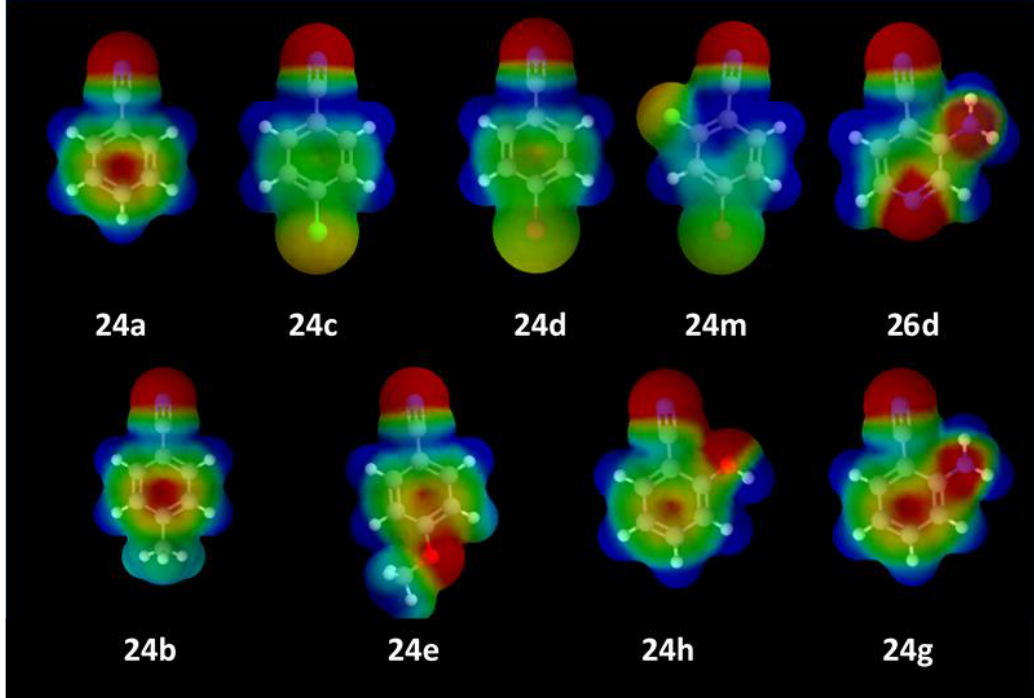
Figure 5. MEP diagrams. Blue indicates electron deficient and red electron rich areas, respectively.